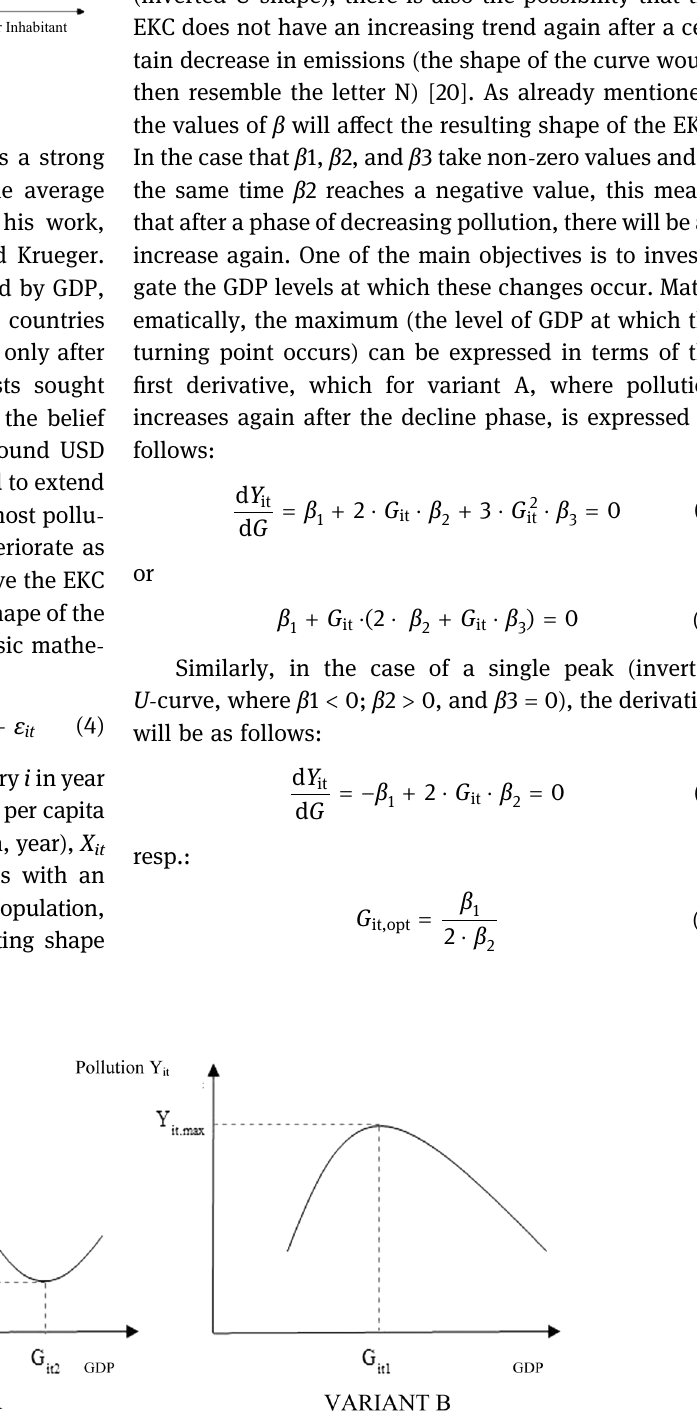
Figure 4: Possible shapes of the